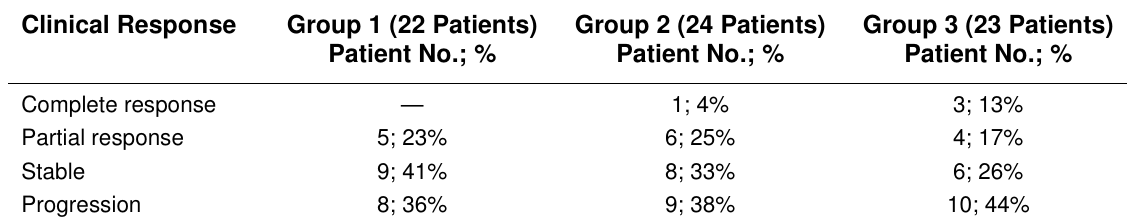
Response to Treatment with Respect to the Group at the End of 3 Months, Starting from